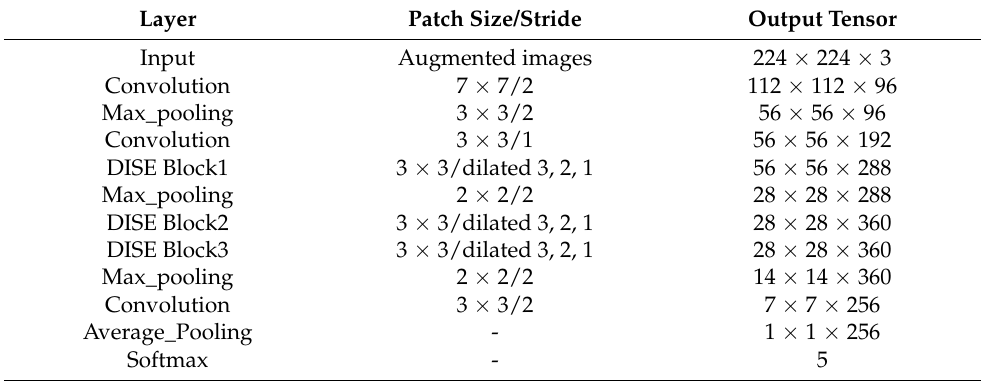
Table 3. Main parameters of DISE-Net